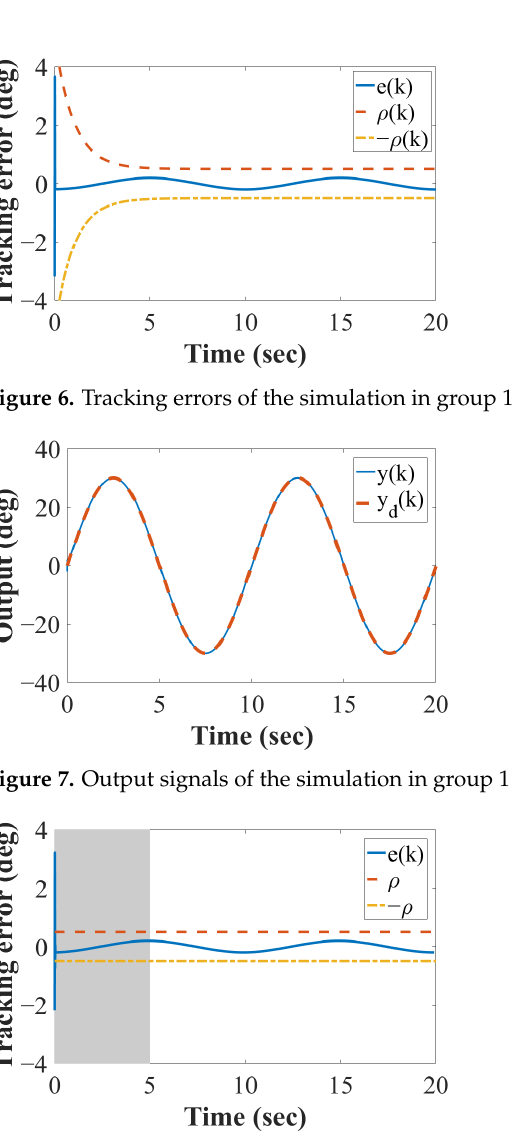
Figure 8. Tracking errors of the simulation in group 1 (proposed method).